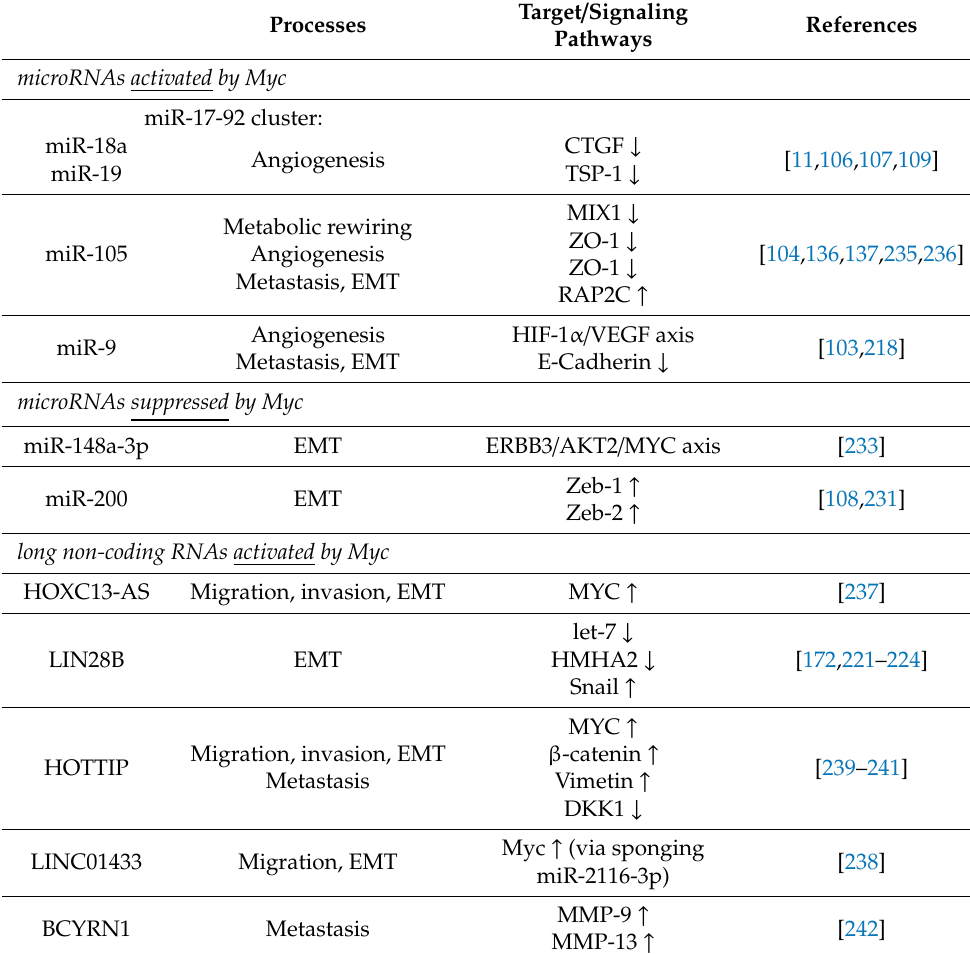
Table 2. The role of non-coding RNAs regulated by MYC involved in cancer aggressiveness and metastasis. A brief summary of non-coding RNAs controlled by MYC, the processes they influence, and the respective targets / signaling pathways mediating these